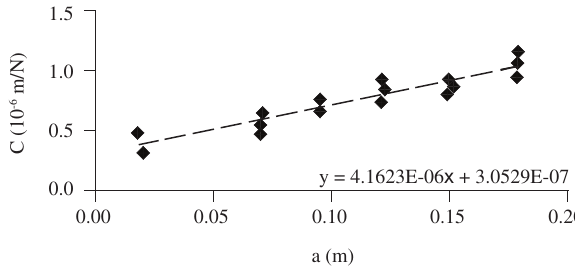
Figure 7. Calibration curve for compliance, C, vs. crack length, a. In this case, a represents the notch length.